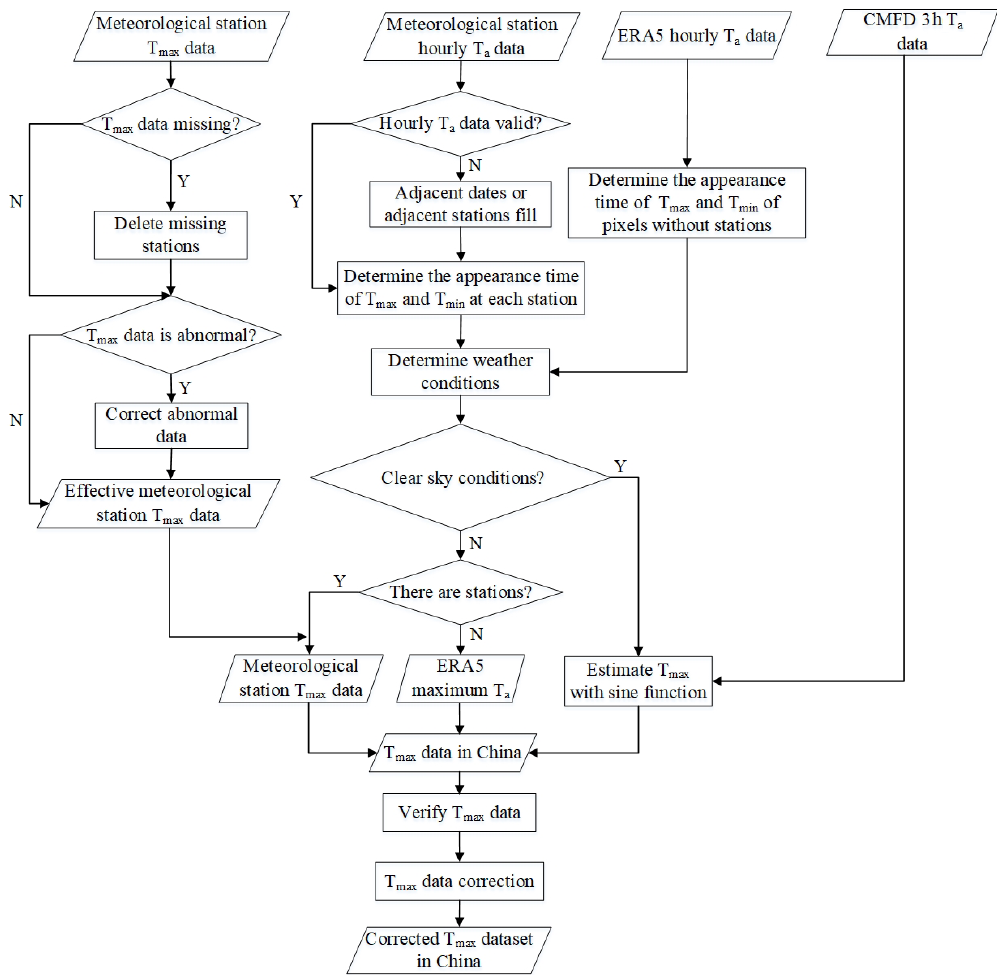
Figure 2. Technical roadmap for T max